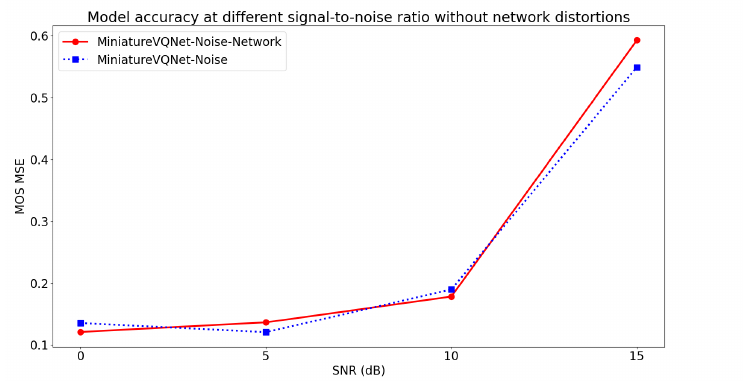
Figure 4. Model accuracy at different signal-to-noise ratios on noisy distorted speech data.